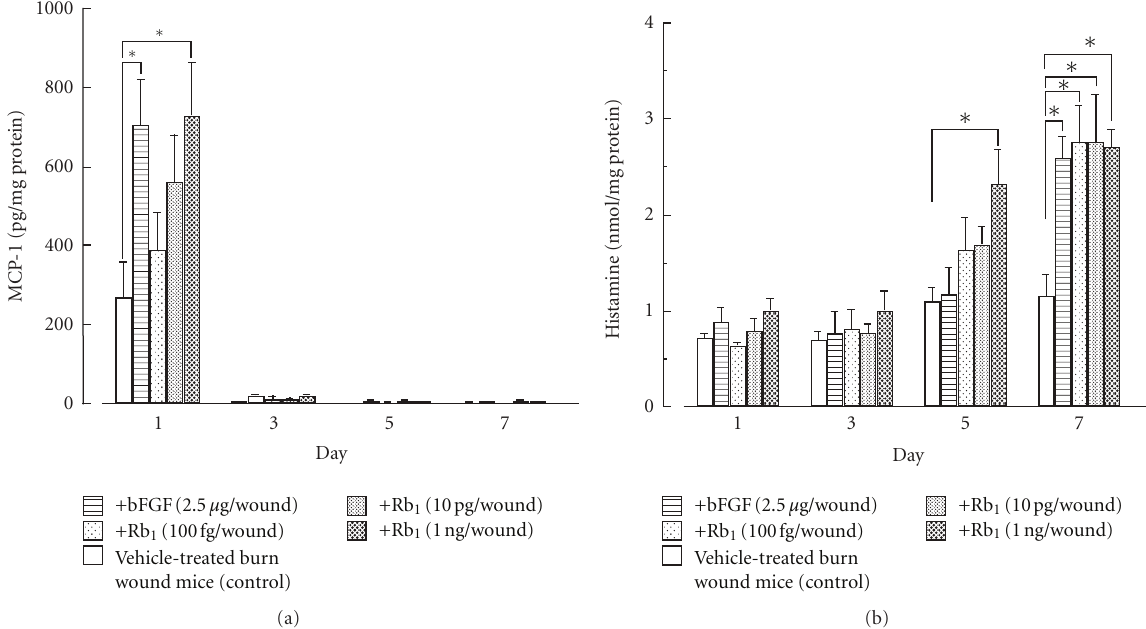
Figure 7: E ff ects of ginsenoside Rb 1 and bFGF on MCP-1 (a) and histamine (b) production in the exudates of burns in male Balb/c mice [27]. The experiments were performed as described in Figure 3, and then MCP-1 and histamine levels in the filter pellets were measured using mouse MCP-1 and histamine ELISA kits, respectively. Values are the mean ± SE for 6 mice. ∗ Significantly di ff erent from control, P < 0 .